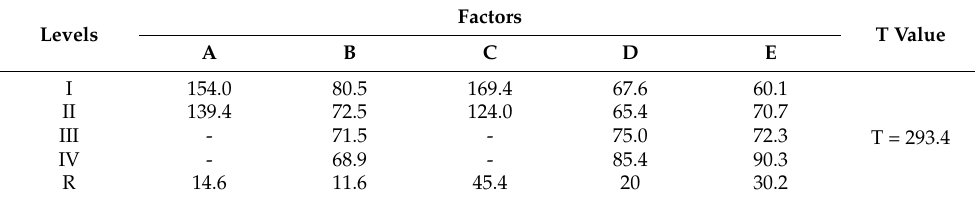
Table 6. Range analysis of the orthogonal experiment of paint film’s gloss GZT